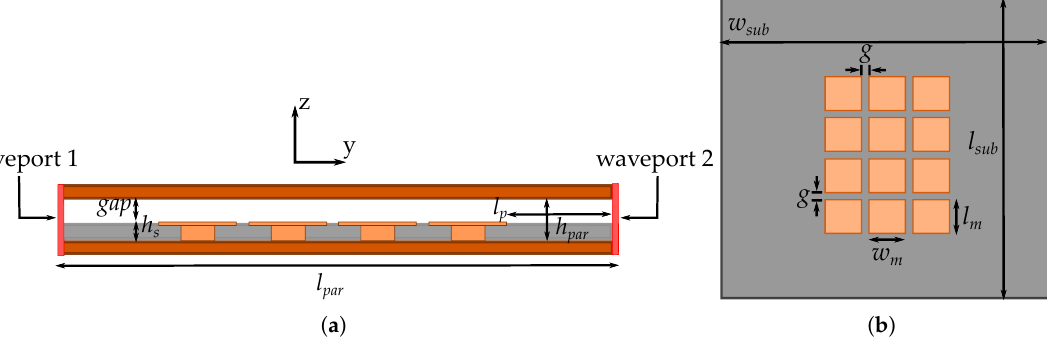
Figure 6. Simulated parallel plate structure. ( a ) Side-view. ( b ) Top-view of the